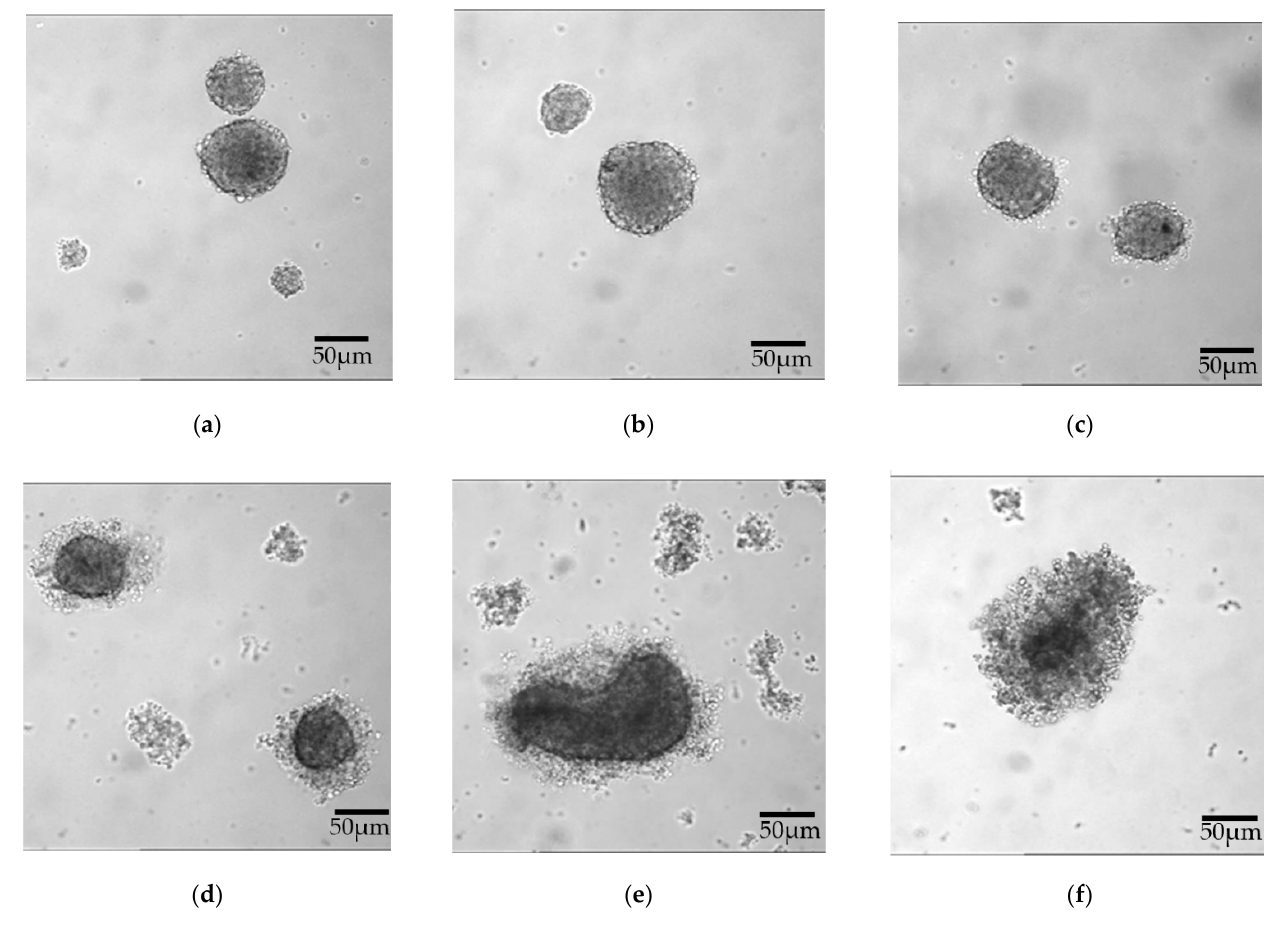
Figure 2. JL-1 sph. after a 48 h treatment with increasing doses of GP-2250: ( a ) control, ( b ) 250 µ mol/L GP-2250, ( c ) 500 µ mol/L GP-2250, ( d ) 750 µ mol/L GP-2250, ( e ) 1000 µ mol/L GP-2250 and ( f ) 1500 µ mol/L GP-2250. With increasing doses, cell–cell contacts of the spheroid periphery are loosened, and singular cells within the spheroid formations can be